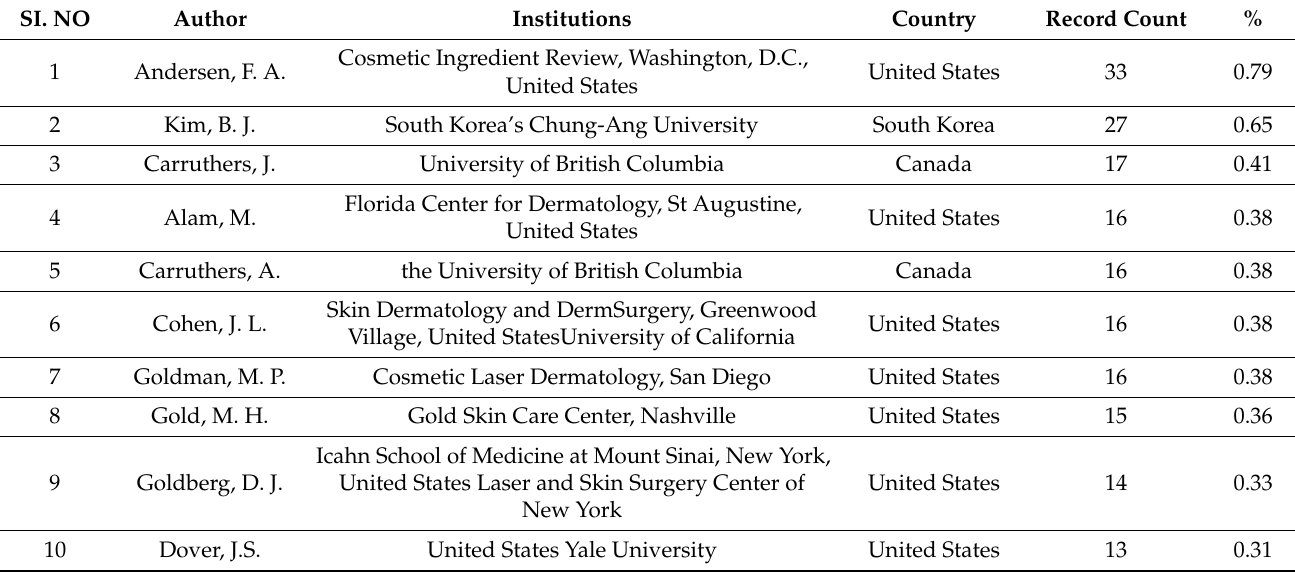
Table 3. The first ten authors by record